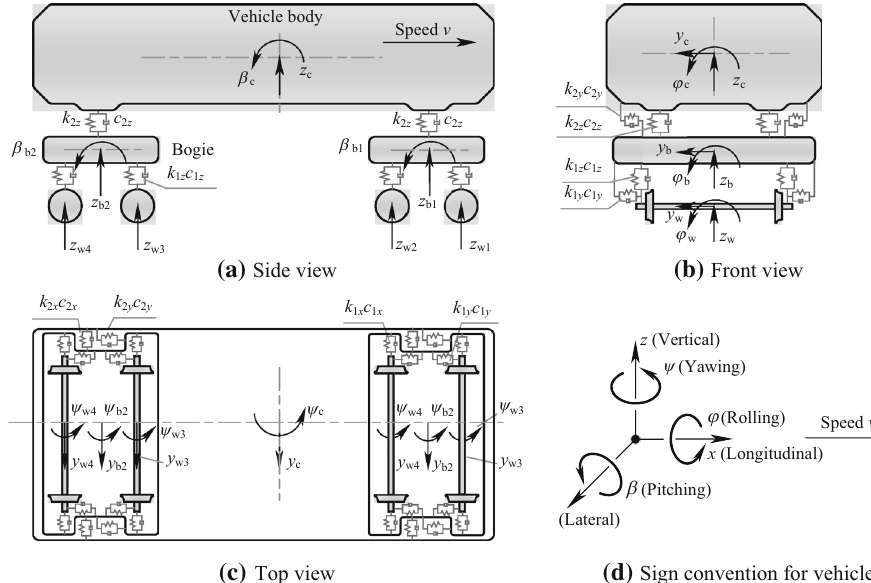
Fig. 2 Vehicle model with corresponding